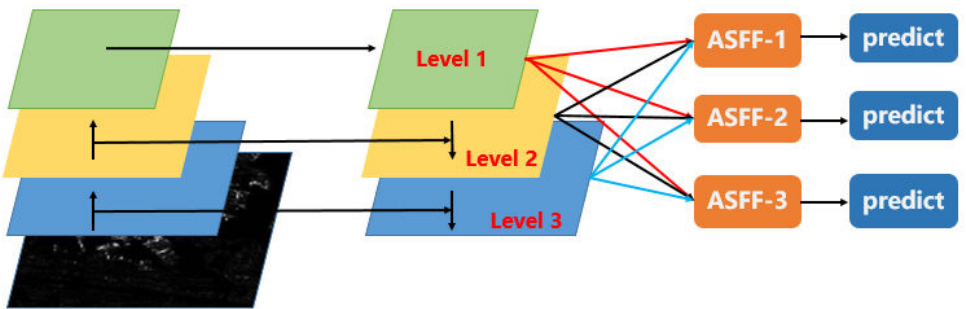
Figure 5. The architecture of the ASFF module. The feature maps of level 1,2,3 are expressed as   ,   ,   , respectively, which can be generated using the pyramid vision transformer. X 1 , X 2 , X 3 , respectively, which can be generated using the pyramid vision